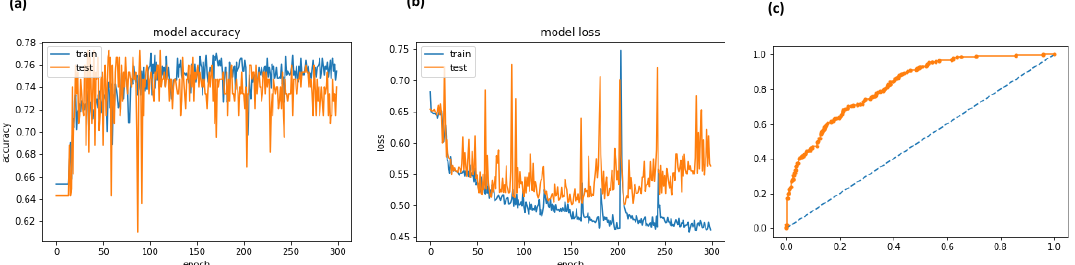
Figure 10. LSTM results (training dataset = 80%, testing dataset = 20%): ( a ) Model accuracy versus epochs; ( b ) model loss versus epochs; ( c ) ROC curve.